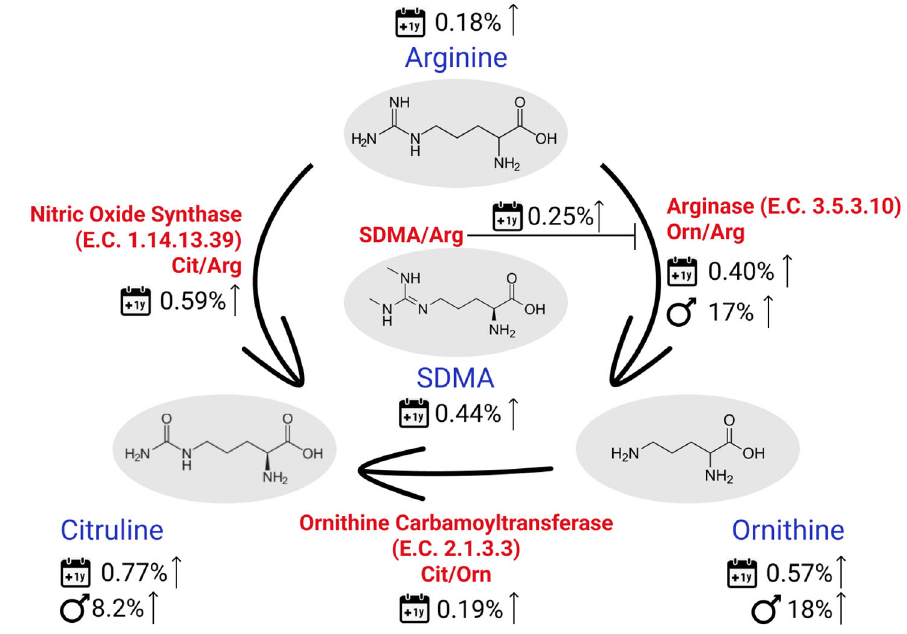
Figure 5. Sex ‐ and age ‐ related (1 ‐ year span) findings on the main metabolites and metabolites ratios Figure 5. Sex- and age-related (1-year span) findings on the main metabolites and metabolites ratios involved in the urea cycle. involved in the urea